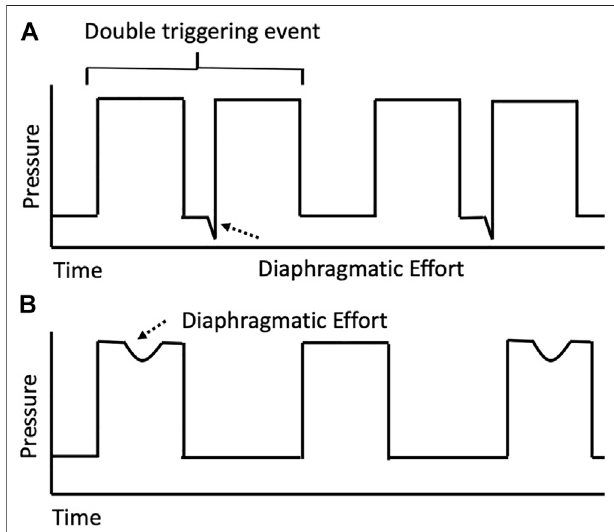
FIGURE 1 | Simpli fi ed pressure-time curve for possible reverse triggering event. This simpli fi ed schematic provides an overview of a reverse triggering event. (A) Passive ventilator breaths followed by a discordant diaphragmatic effort during expiration in a 1:1 entrainment ratio. Such diaphragmatic efforts, if initiated in or persisting beyond the ventilator refractory period and signi fi cant enough to exceed the set trigger, will result in double-triggering as shown. (B) Passive ventilator breath with a diaphragmatic effort during the inspiratory phase in a 1:2 entrainment ratio. In this example, the diaphragmatic effort during the ventilator refractory period results in an apparent early or ineffective trigger.